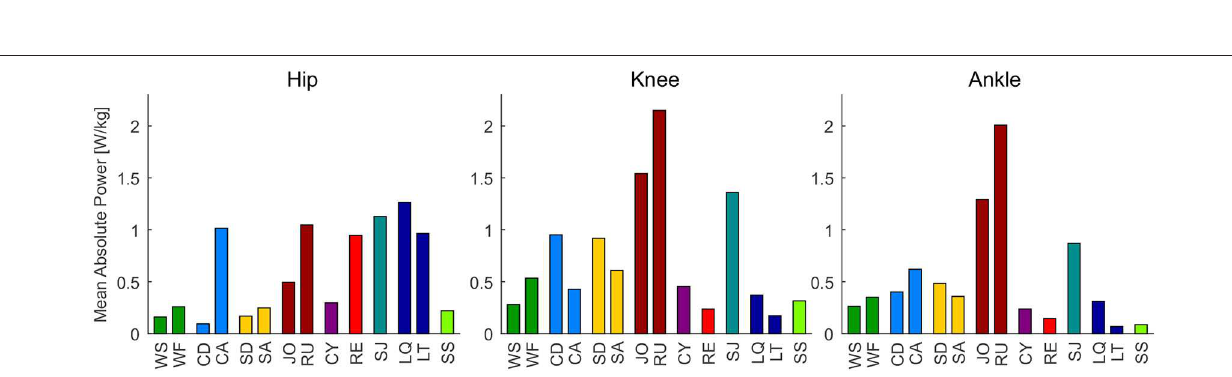
FIGURE 5 | Mean absolute hip, knee and ankle power for the analyzed movements. From let to right: walking slow (WS), walking fast (WF), climbing descend (CD), climbing ascend (CA), stair descend (SD), stair ascend (SA), jogging (JO), running (RU), cycling (CY), recovery (RE), squat jump (SJ), squat lifting (LQ), stoop lifting (LT), sit to stand (SS).